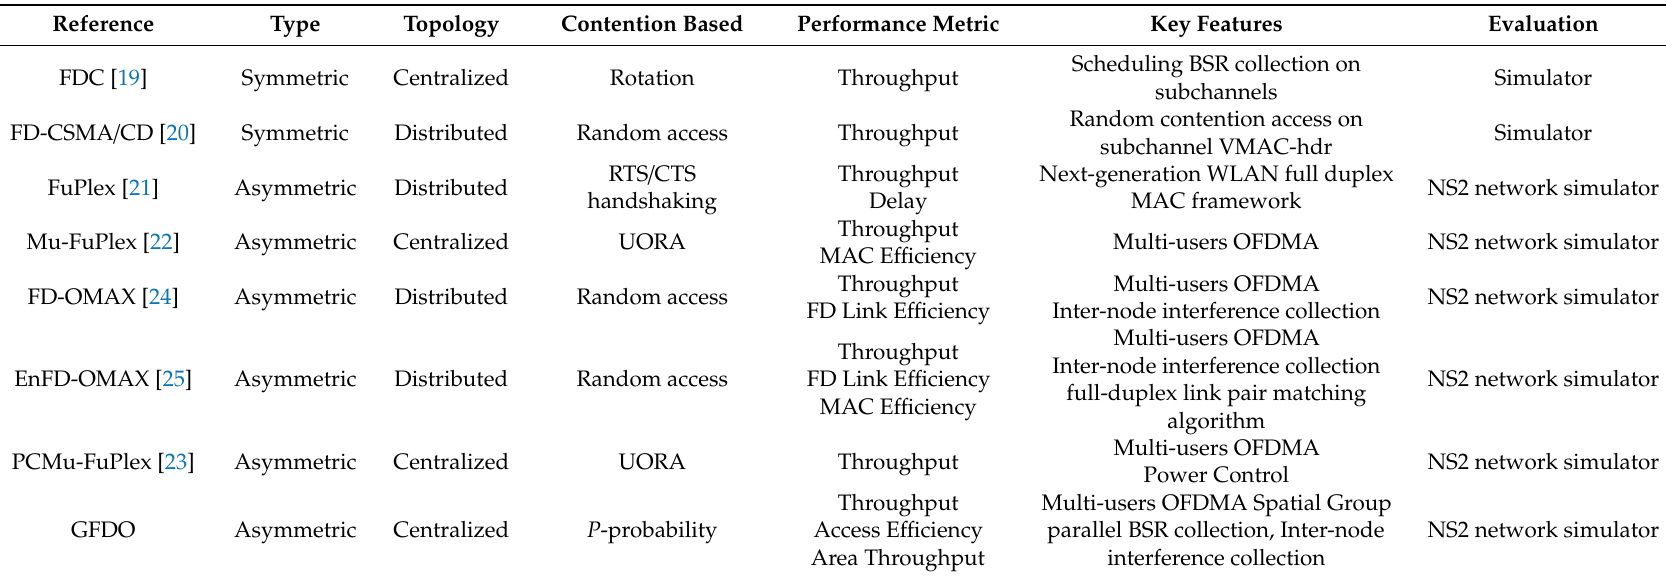
Table 1. Comparison of MAC protocol for Co-time Co-frequency Full Duplex (CCFD)